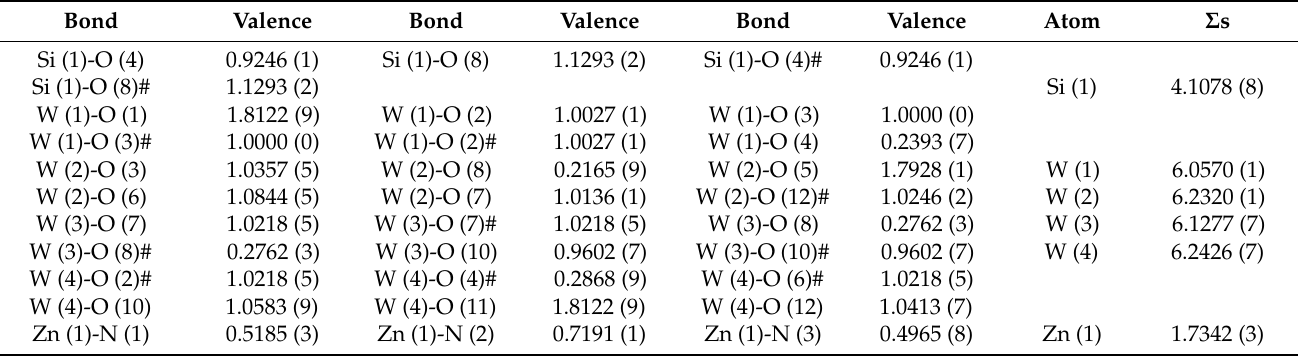
positive charges in ZSW occurs in the [SiW 12 O 40 ] 4– skeleton, which probably facilitates proton absorption and, by extension, valence state balancing upon valence alteration of metal ions [39]. Table 2. Bond valence and Σ s of Si, W, Zn in ZSW.